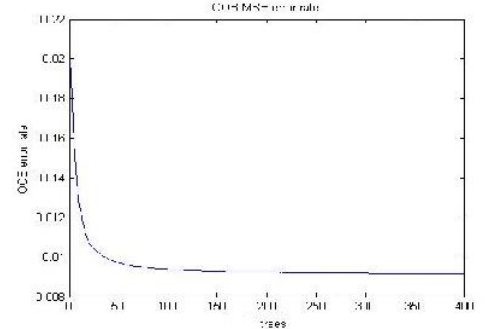
Figure 3. Decrease in error as a function of the number of trees for RFR